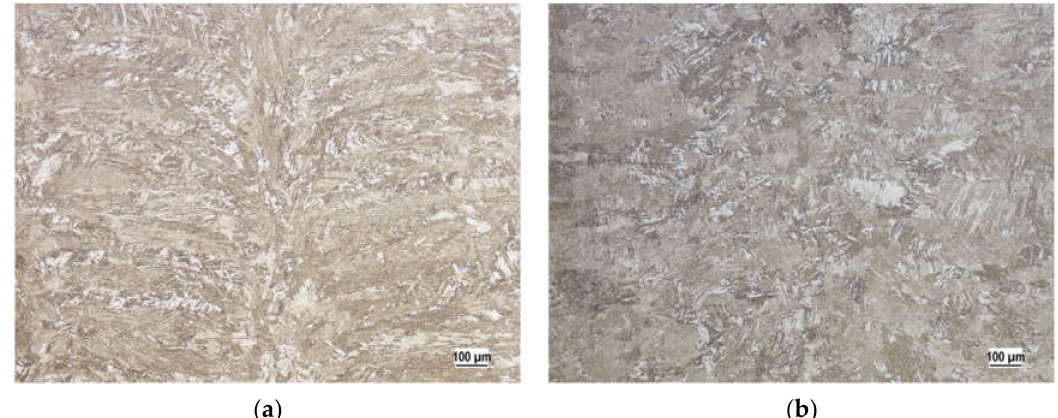
Figure 9. ( a ) The microstructure of the welded metal of the electron beam for the high-strength steel S960 QL. ( b ) The microstructure of the welded metal of the laser beam for the high-strength steel S960 QL.